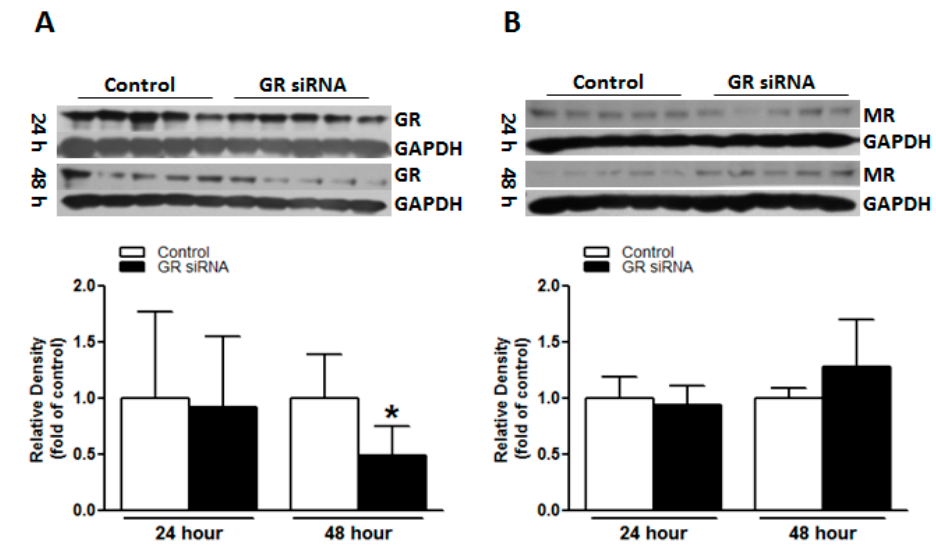
Figure 1. The glucocorticoid receptor (GR) siRNA repressed GR expression in mice brain. The mice received either GR siRNA (100 pmol) or its negative control (Neg. Control; 100 pmol) via intracerebroventricular (i.c.v.) injection. The brain samples were collected at 24 h and 48 h after i.c.v. treatment. Glucocorticoid receptor (GR) protein abundance ( A ) and mineralocorticoid receptor (MR) protein abundance ( B ) were determined via western blotting at 24 h and 48 h, respectively. n = 5. * p < 0.05, GR siRNA vs Control.